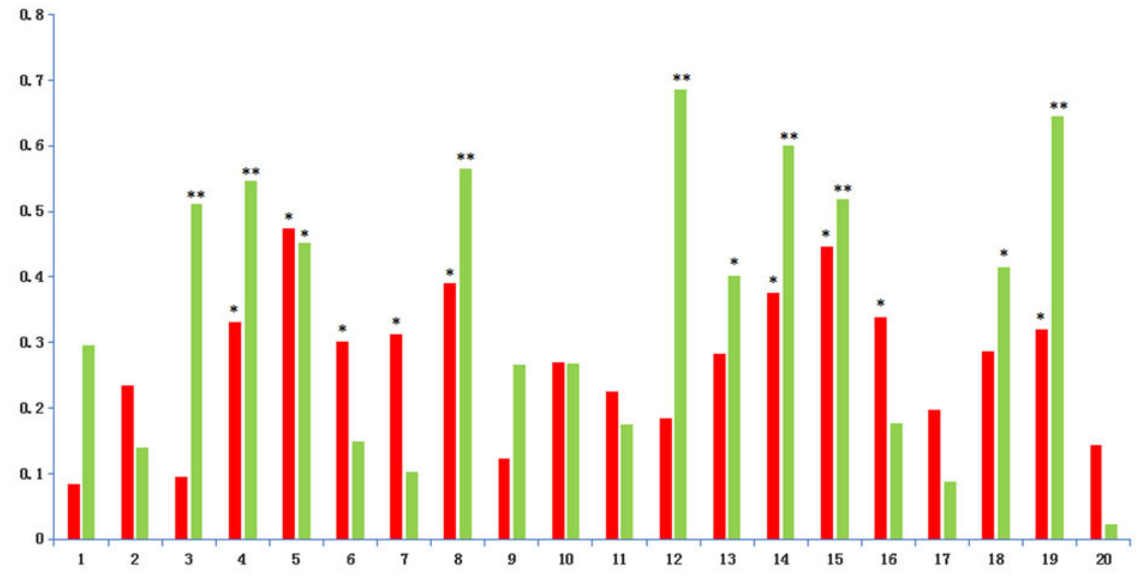
Figure 5: Bivariate analysis of the compounds identified in Cistanche . SPSS version 21.0 was used to analyze the data. The red column is the uterine indices, and the green column is the MCF7 cell proliferation. The correlation coefficients higher than 0.3 were considered significant (*p < 0.05), whereas correlation coefficients higher than 0.5 were considered highly significantly (**p < 0.01). These thirteen compounds exerted oestrogenic activities. Compounds that significantly correlated with uterine weight and cell proliferation were 8-epiloganic acid, salidroside, syringalide A3’-α- l-rhamnopyranoside, cistanoside A, cistanoside B, cistanoside C, osmanthuside B, acteoside, isoacteoside, tubuloside B, 2’-acetylacteoside, and two unknown compounds.